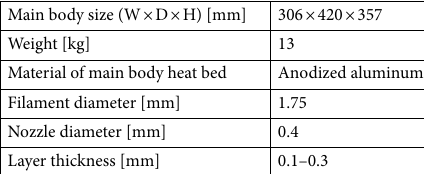
Table 1. Specifications of the tested 3D